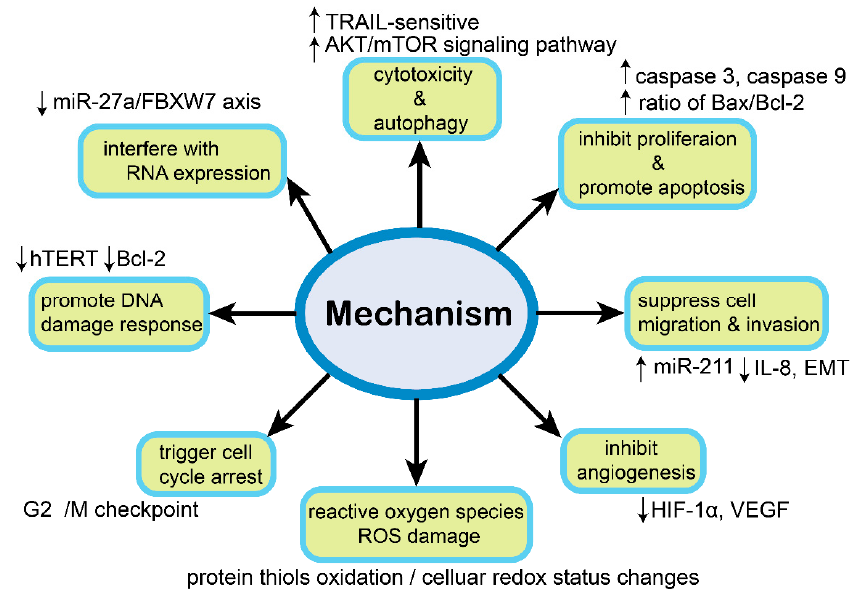
Figure 2. The role of molecular mechanisms in ovarian